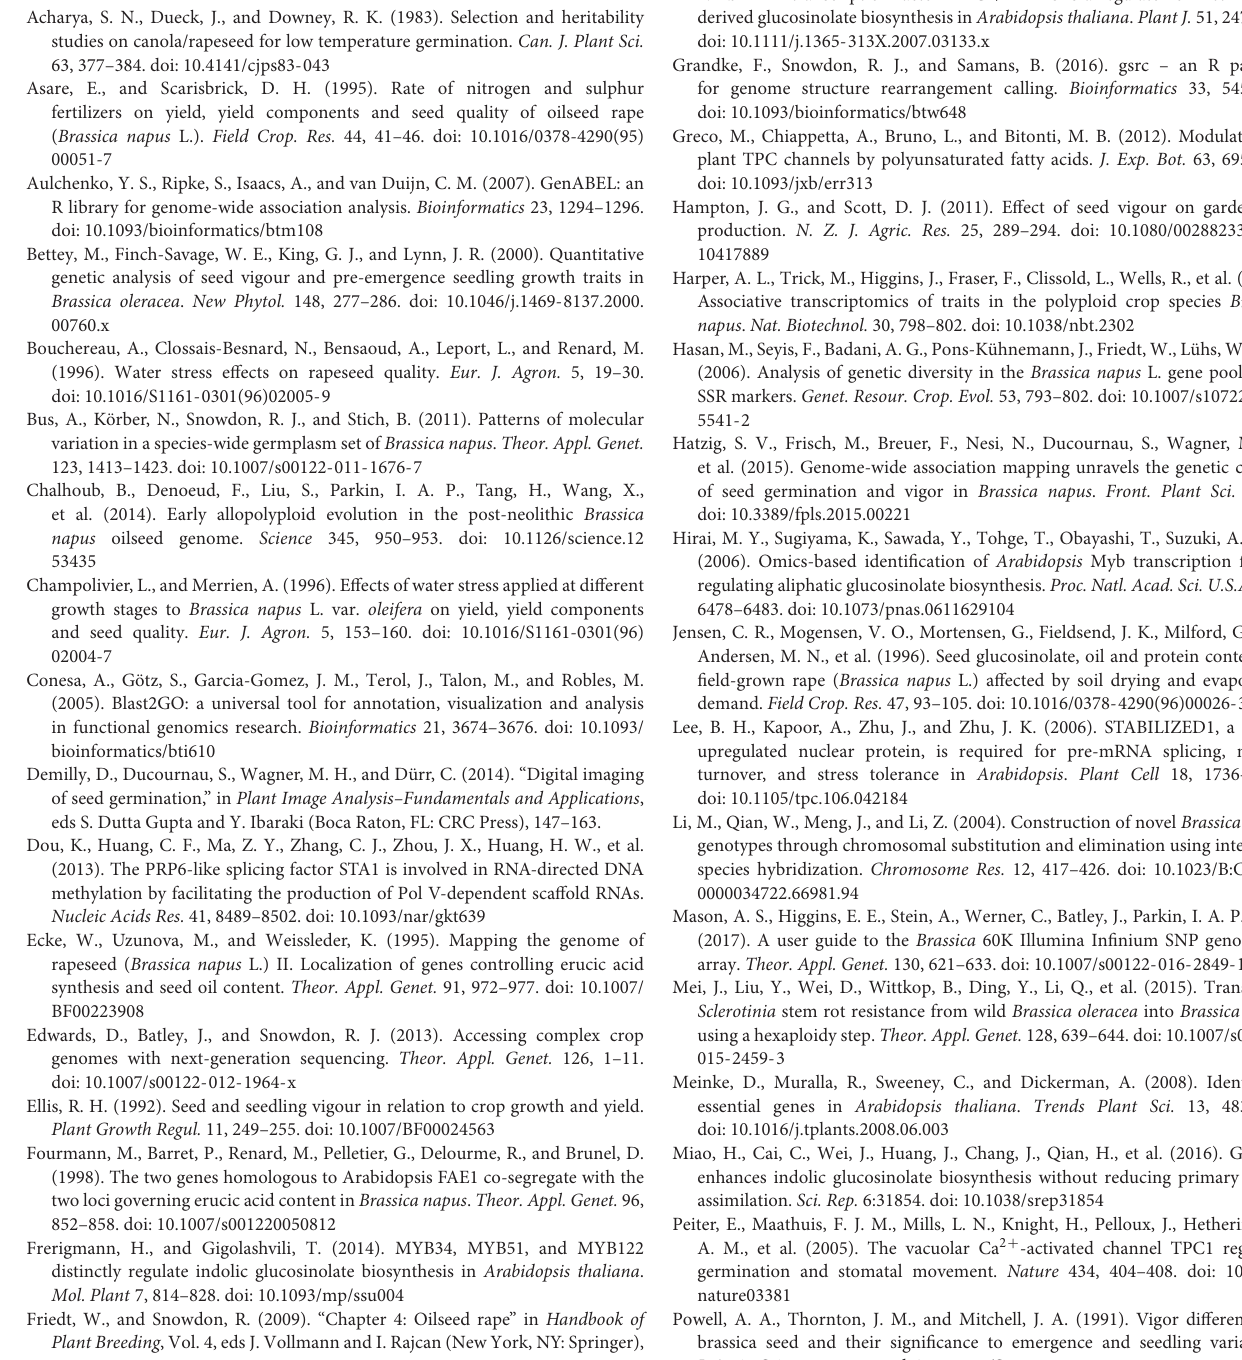
TABLE S1 | List of all SNP markers which are significantly associated with mean germination time (MGT), seed erucic acid (EA) content, and seed glucosinolate (GSL) content along with their corresponding − log 10 - p -values calculated for seed